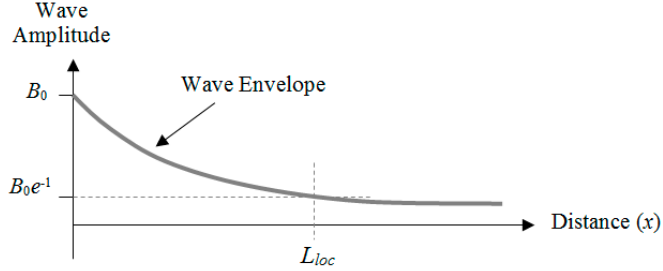
Figure 6. Wave localization by random pipe diameter non-uniformities.